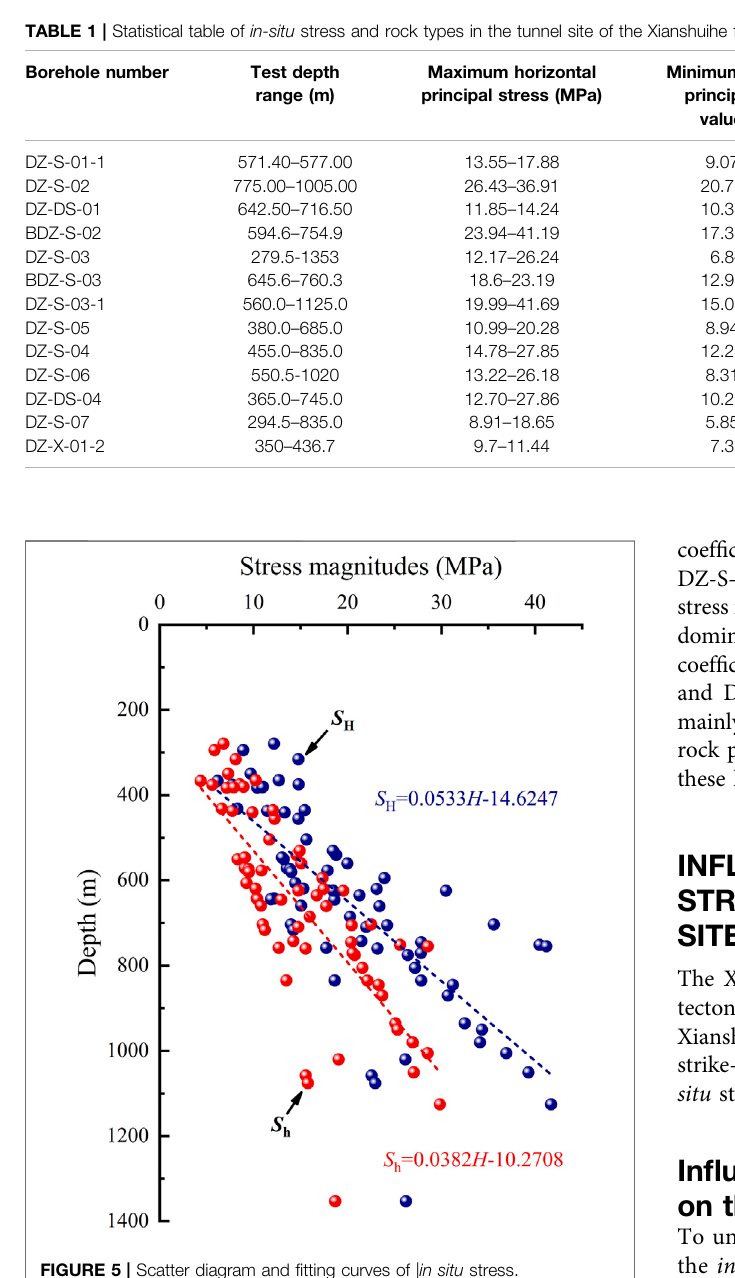
Frontiers in Earth Science |